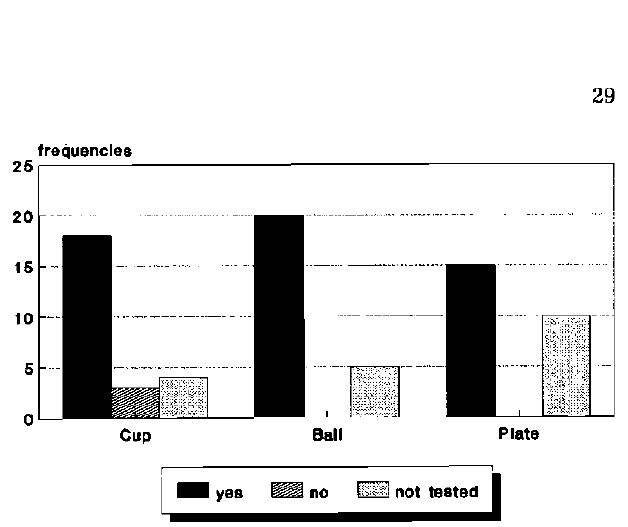
Figure 2: Frequency for tester-child receptive abilities ties, it was found that 54% of children understood the ques-